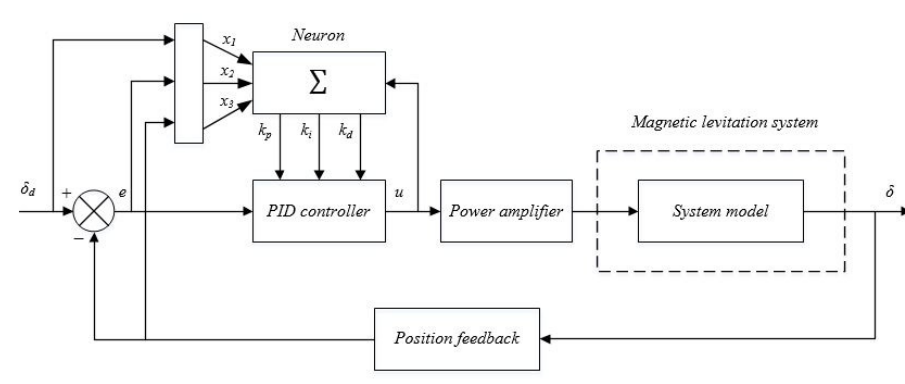
Figure 4. System control block diagram.